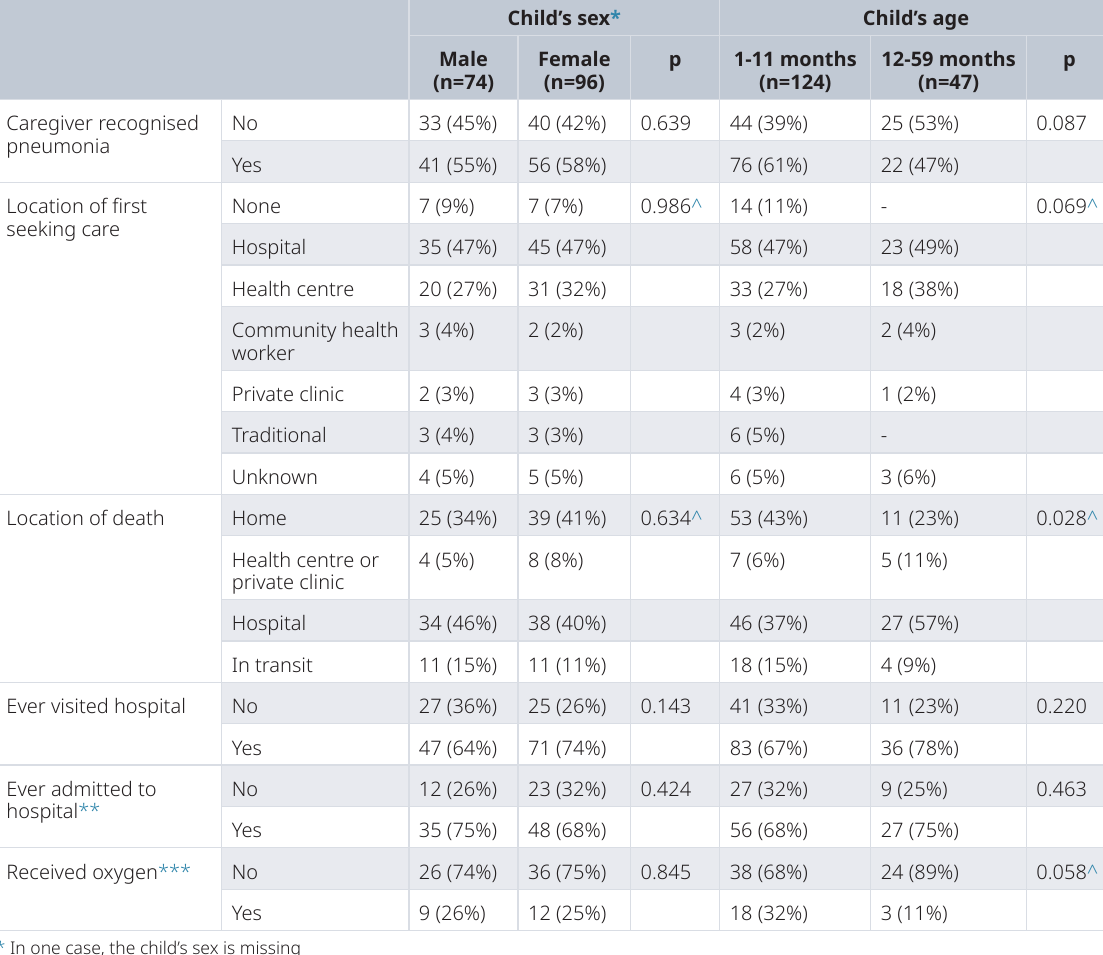
Table 4. Description of care-seeking behaviour, according to age and sex.